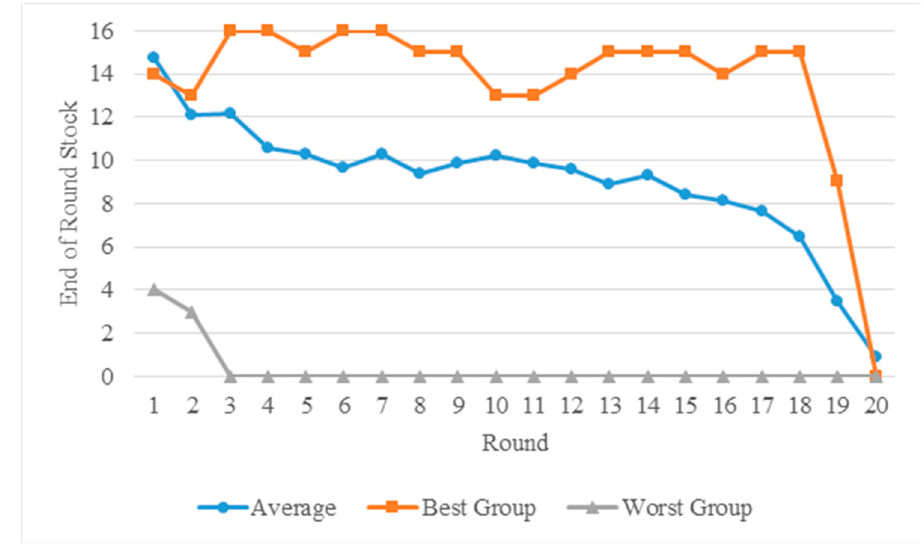
Figure 2. Stock at the end of each round.